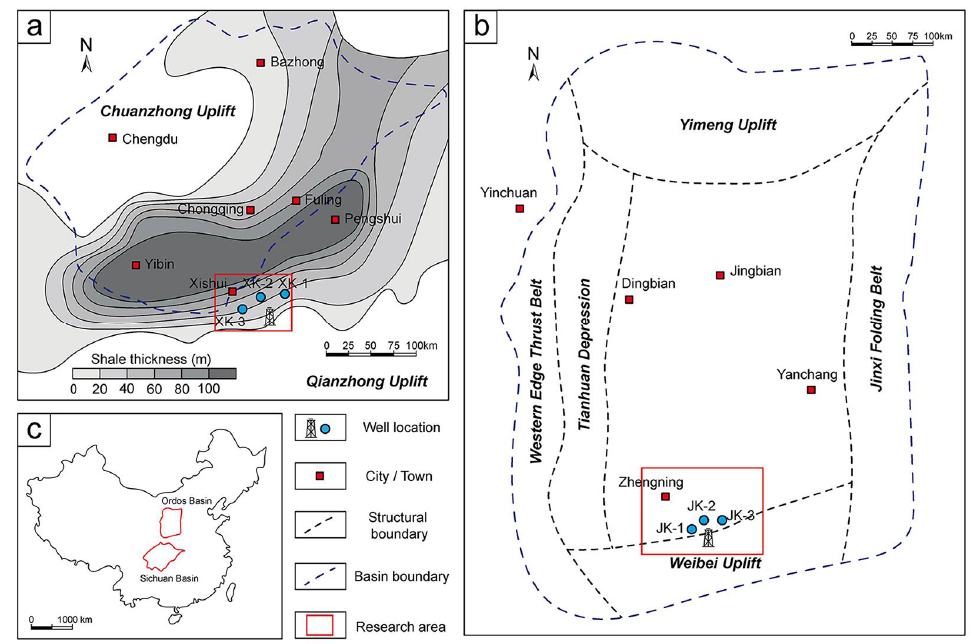
Figure 1. Location of Longmaxi Formation in Sichuan Basin ( a ) and Yanchang Formation in Ordos Basin ( b ); The location map of the Sichuan and Ordos Basin in China ( c ).